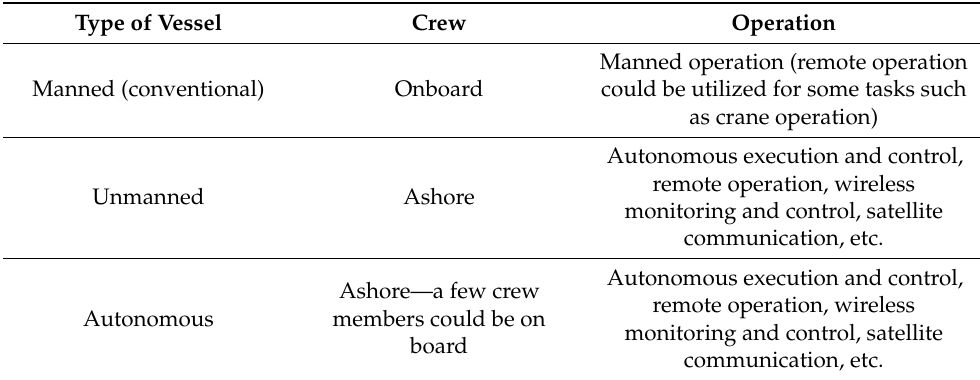
Table 1. Three types of vessels and remote ship